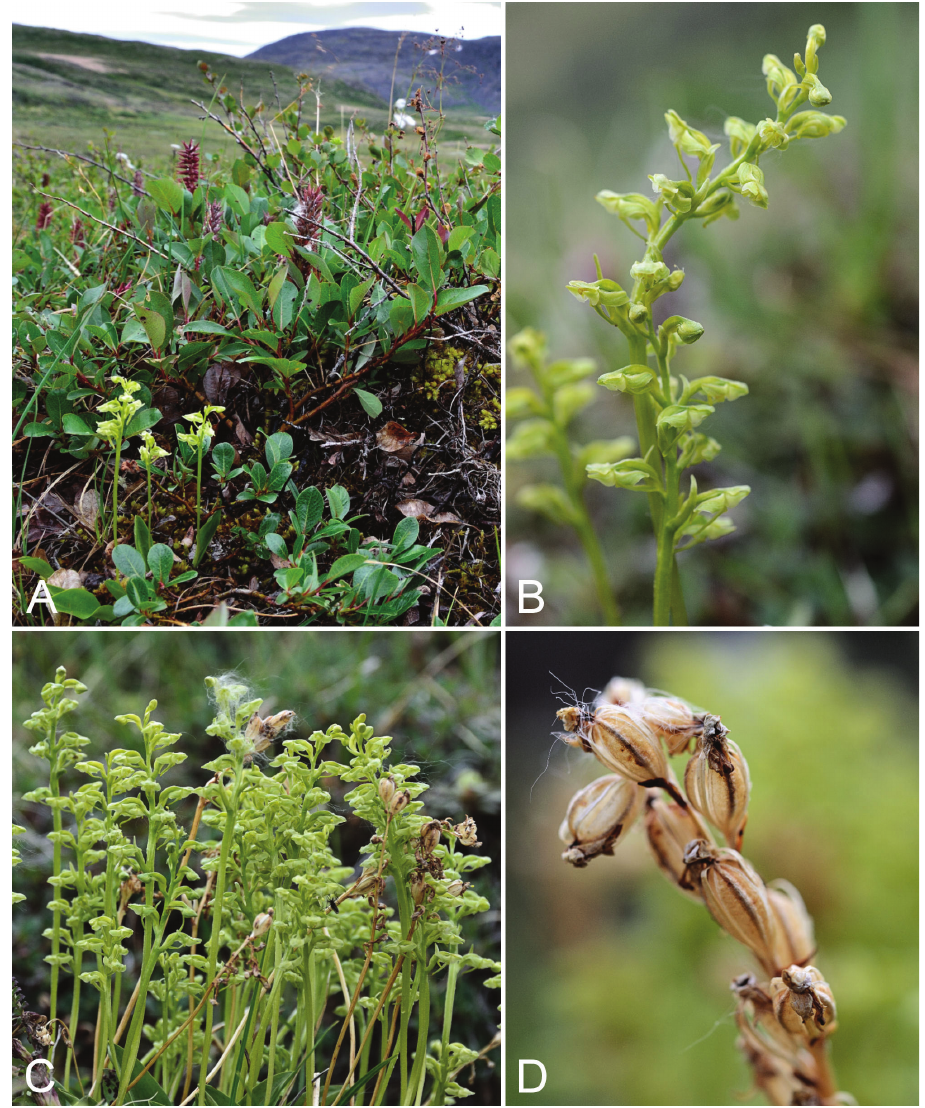
Figure 6. Platanthera obtusata subsp. obtusata : A habitat, Saarela et al. 2197 B inflorescence C habit D old fruits, Saarela et al. 2209 . Photographs by R.D.